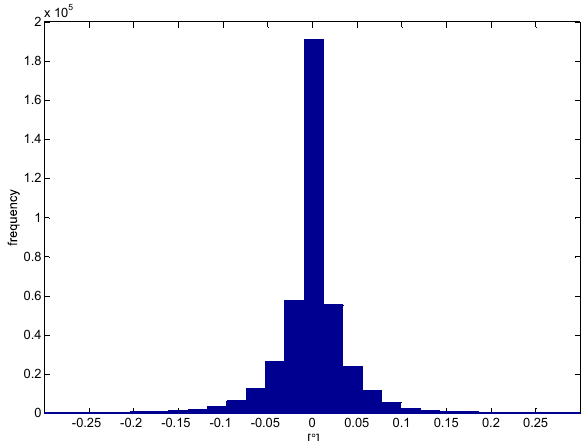
Figure 7: Histogram of the angle residuals plotted in the range of − 0 . 3 ◦ to 0 . 3 ◦